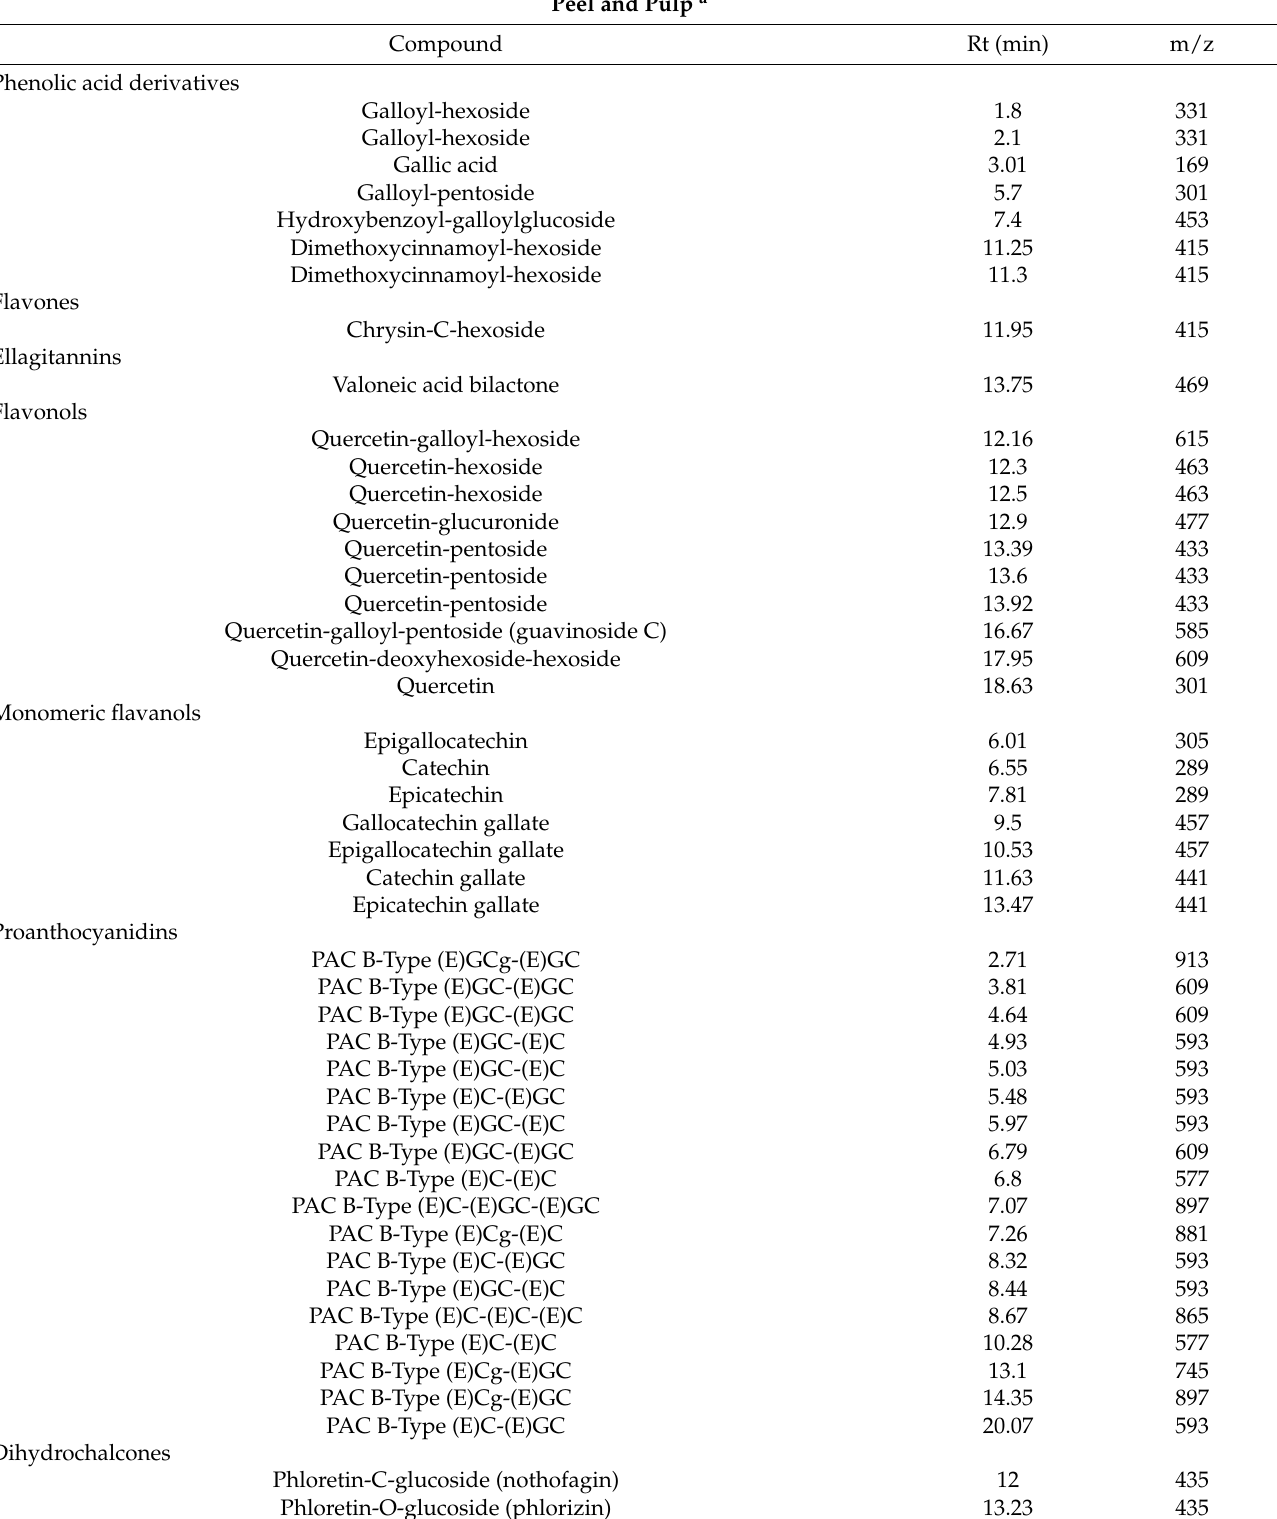
Table 3. Phenolic compounds identified in the peel, pulp, and leaves of P. guajava